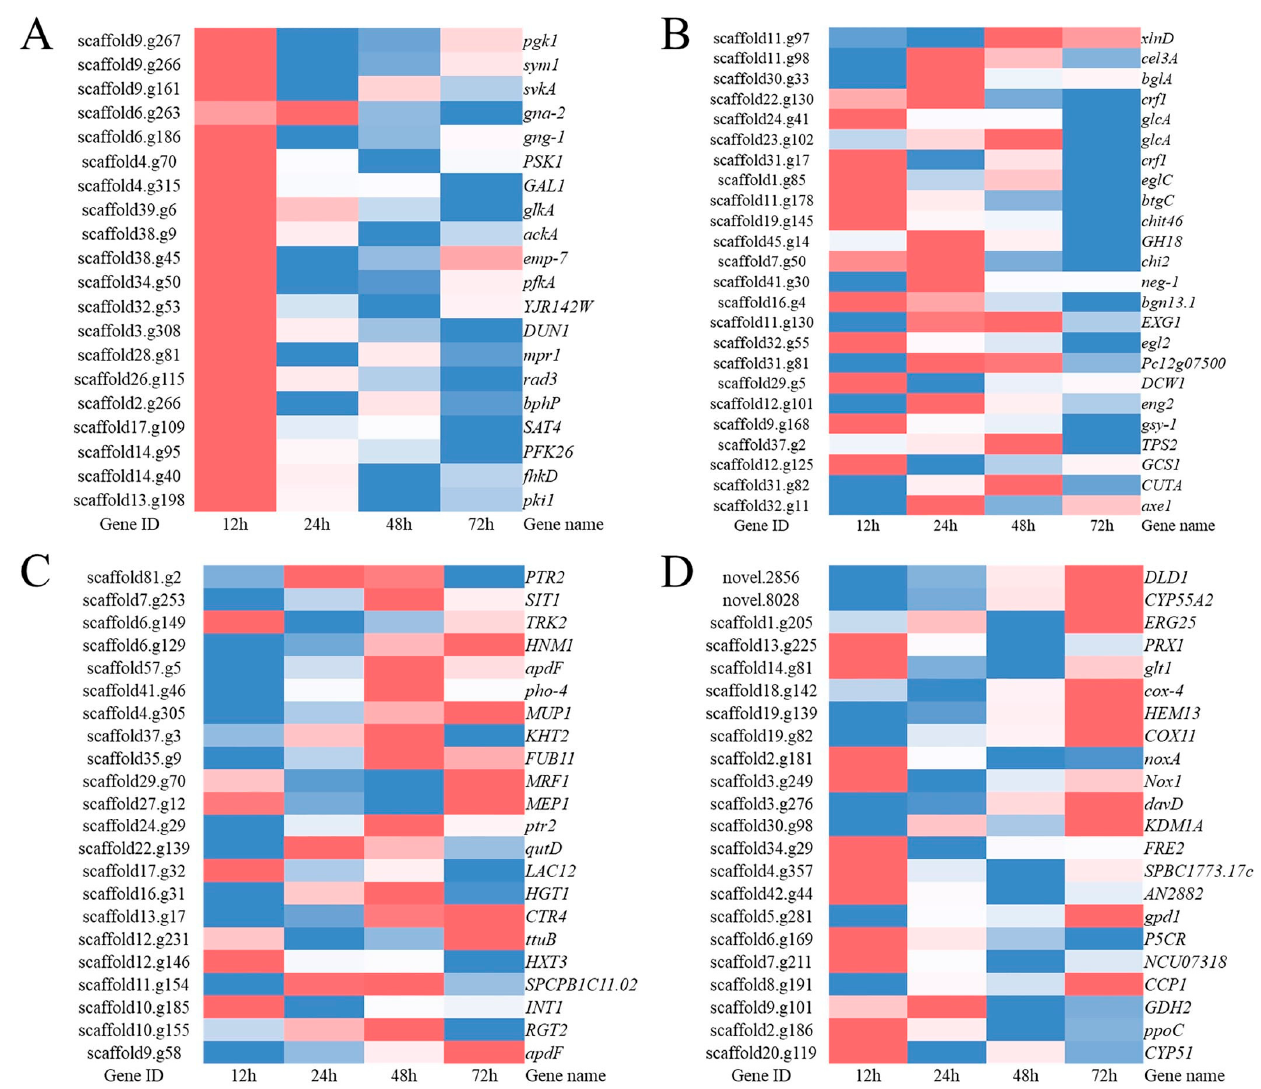
Figure 5. Heatmap of the DEGs involved in ( A ) signal transduction and kinase activity; ( B ) carbohydrate activity enzymes; ( C ) transmembrane transport and transporter; and ( D ) antioxidant proteins in T. harzianum T4 samples treated with BCCW at different time points (12, 24, 48 and 72 h).